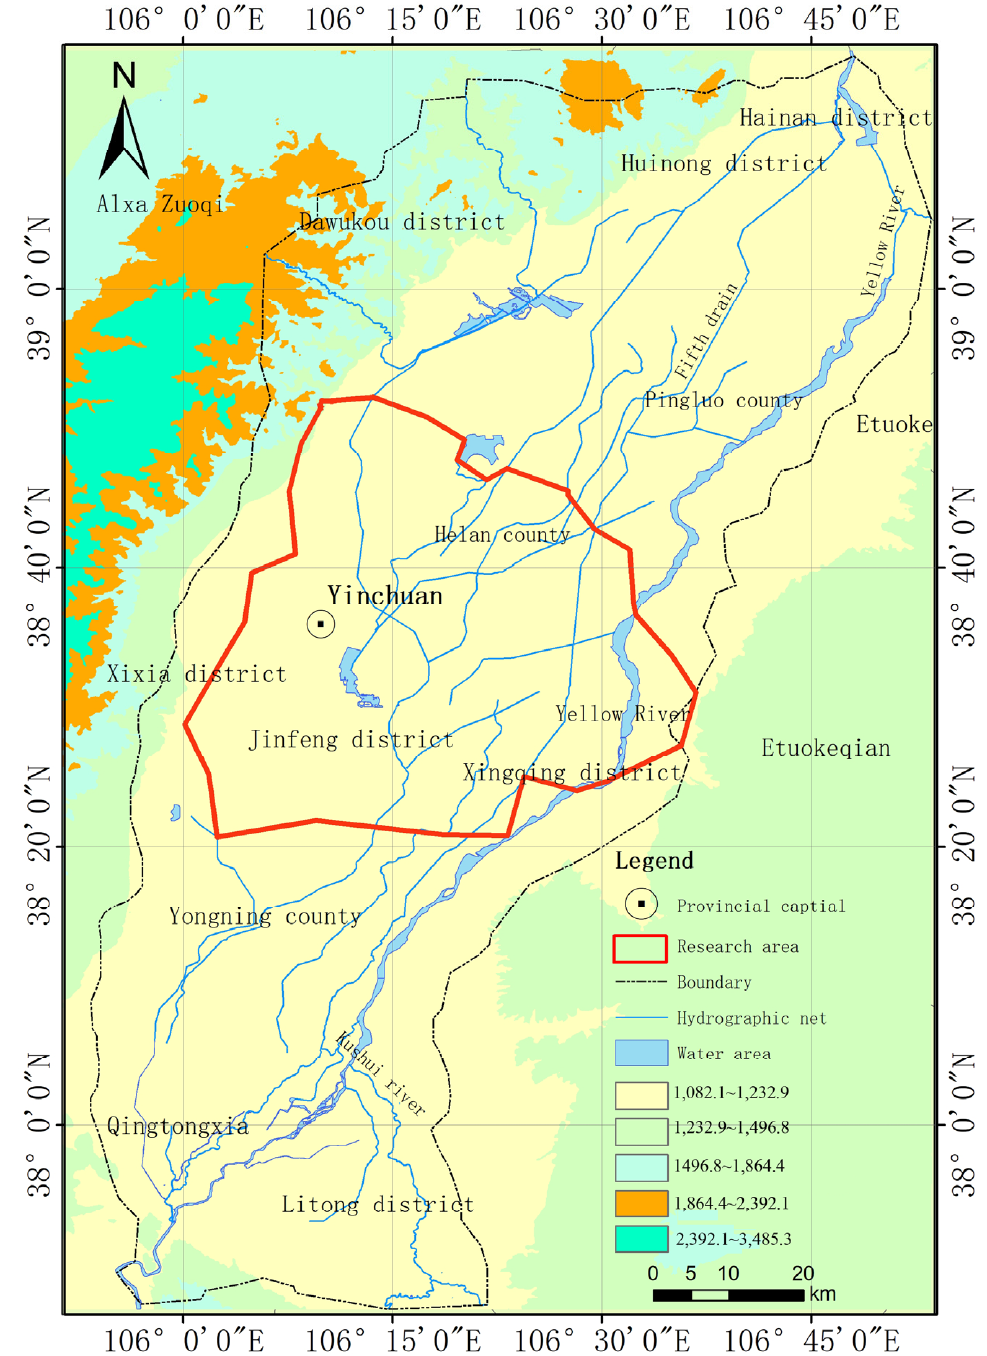
Figure 1. Study area, geological profile, and location of samplings.